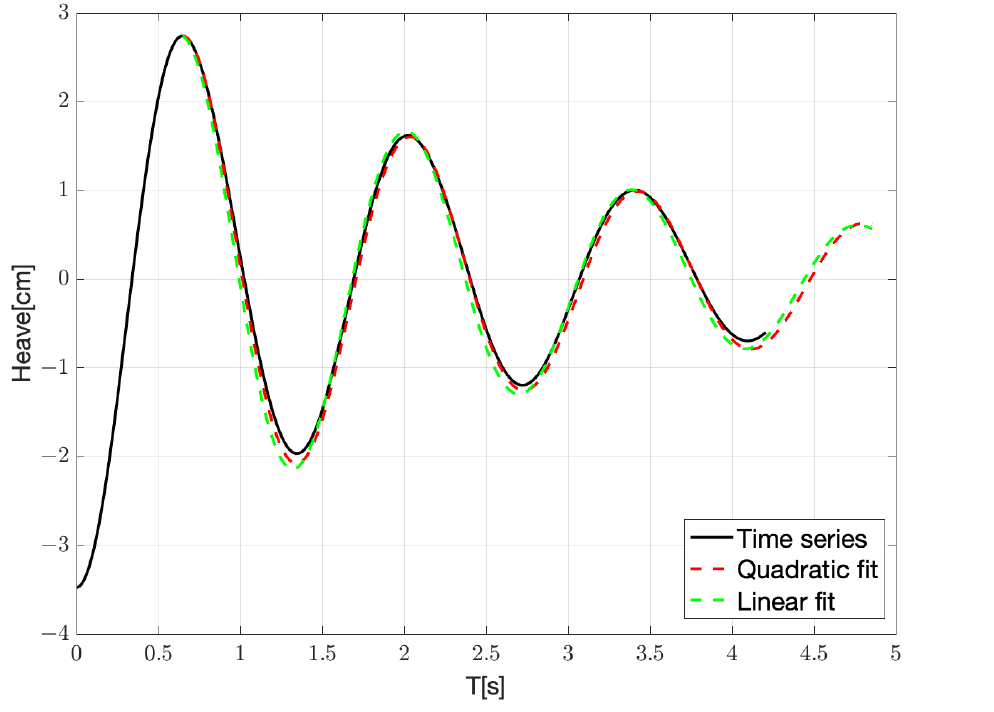
Figure 15. Time series and fit curves of the free decay test of heave obtained from CFD simulation with